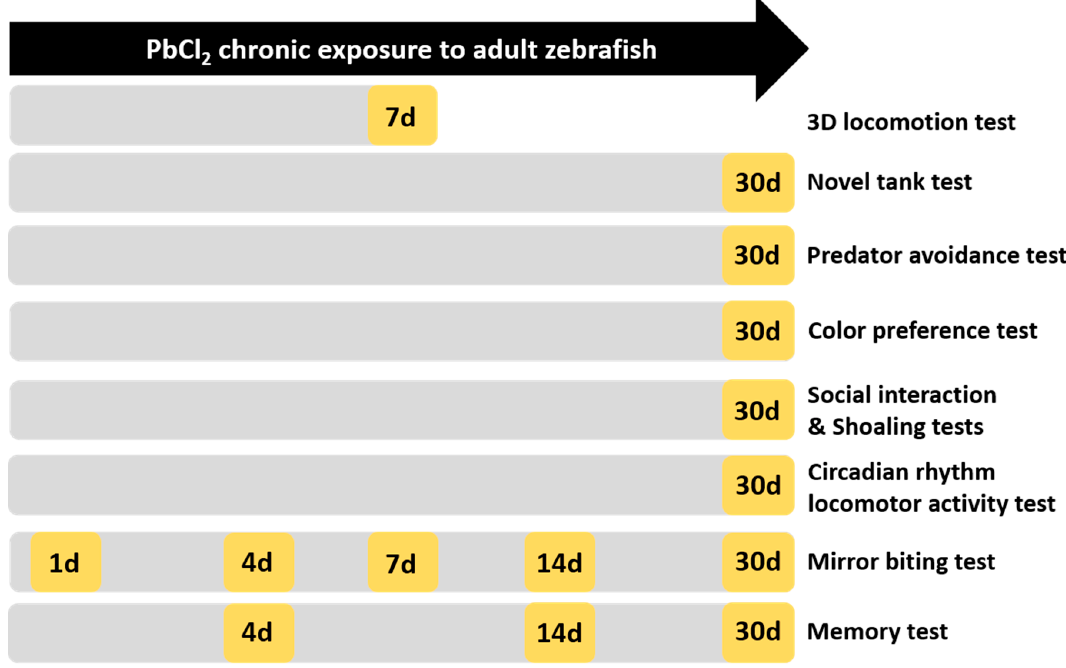
Figure 1. Schematic diagram of the evaluation of the neurobehavioral toxicity of PbCl 2 in zebrafish. Yellow indicates the time points (day) for conducting behavioral assays. After 30 days, all fish were sacrificed and the biochemical assays were performed.